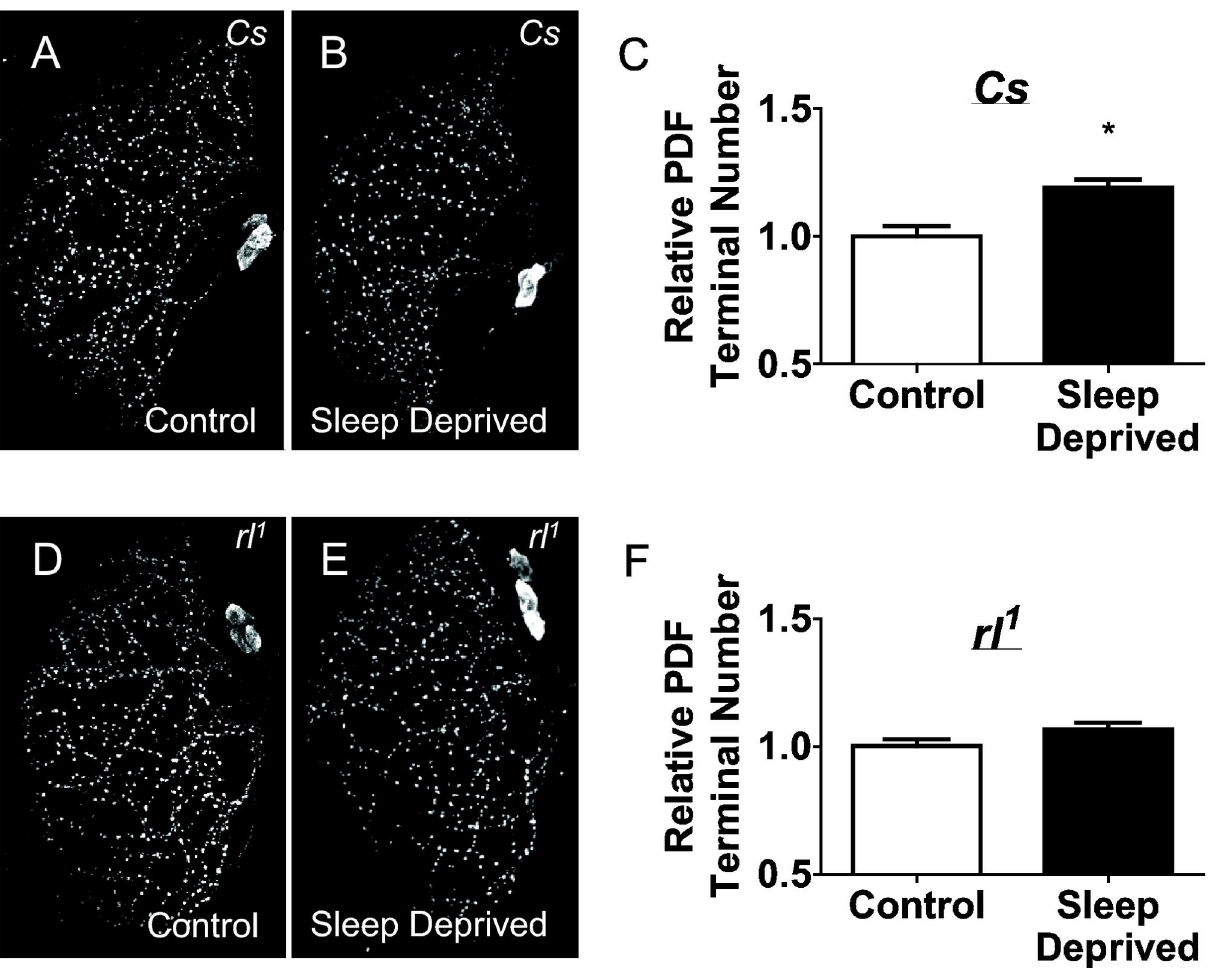
Figure 3. Sleep deprivation alters structural plasticity. A - B , Immunohistochemistry of pigment dispersing factor (PDF) in brains of wild-type Cs flies that experienced either a full night of sleep ( A ) or 12 hours of sleep deprivation ( B ). C , Quantification of PDF immunohistochemistry in A - B . 12 h of Sleep deprivation significantly increases PDF-positive terminals, p = 0.0011, student’s t-test, n= 13-14/group. Values normalized to non-sleep deprived controls and presented as mean ± SEM (* = p < 0.05). D - E , Immunohistochemistry of pigment dispersing factor (PDF) in brains of rl 1 mutant flies that experienced either a full night of sleep ( D ) or 12 hours of sleep deprivation ( E ). F , 12 h of sleep deprivation did not alter the number of PDF-positive terminals, p = 0.083, student’s t-test, n= 16-17/group. Values normalized to non-sleep deprived controls and presented as mean ± SEM (* = p < 0.05).